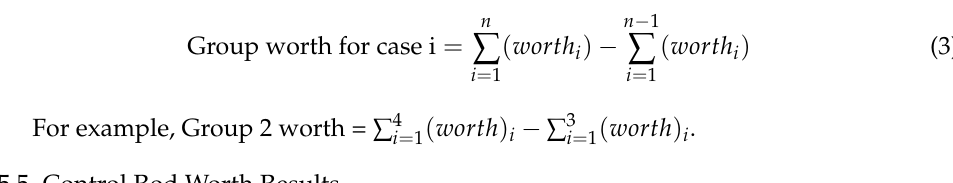
Table 8. Summary of control rod worth results and comparison between MPACT and McCARD.